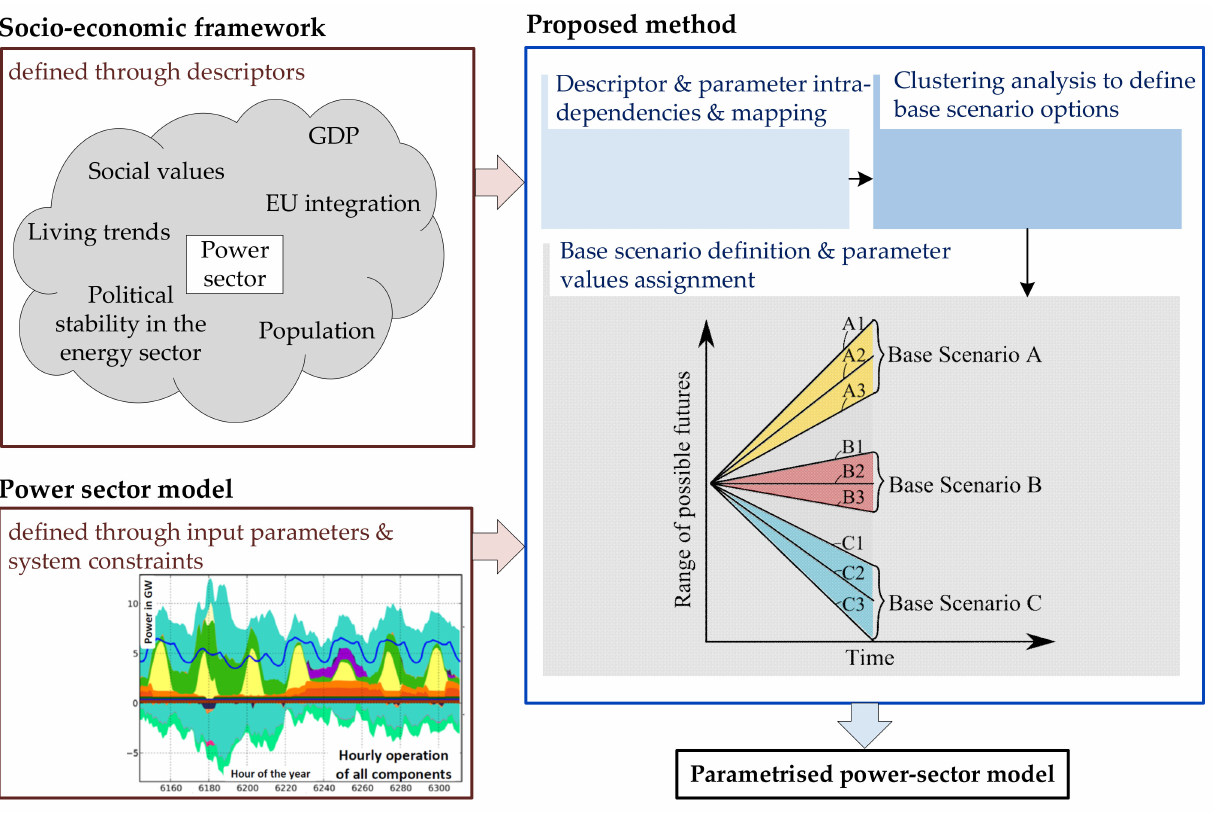
Figure 1. Schematic representation of the parametrisation of power-sector models considering plausible socioeconomic framework scenarios. Each resulting base scenario represents one plausible future (e.g., Base Scenario A) and its variants (e.g., A1, A2,